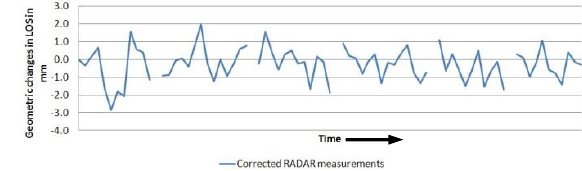
Figure 9: Corrected RADAR measurements of an area with deformations